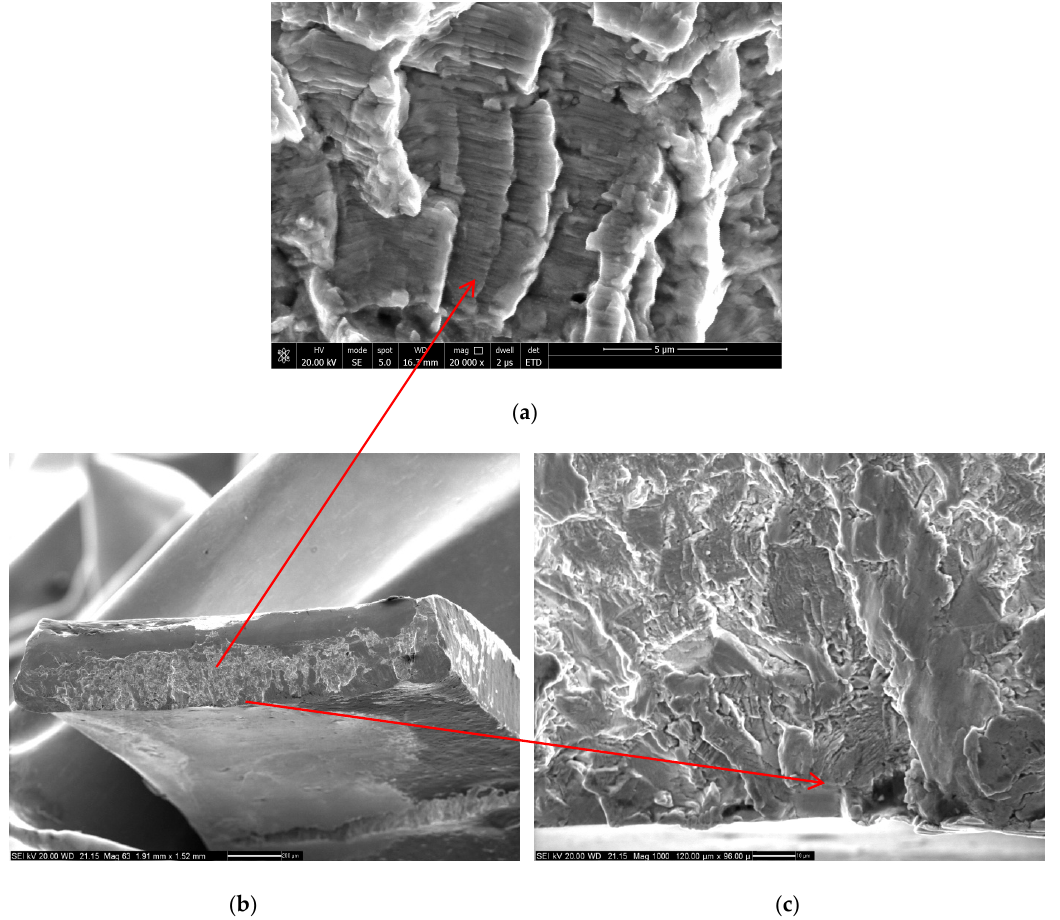
Figure 8. Typical fracture morphology of the cage: ( a ) fatigue striations; ( b ) fracture appearance; ( c ) fracture origin.